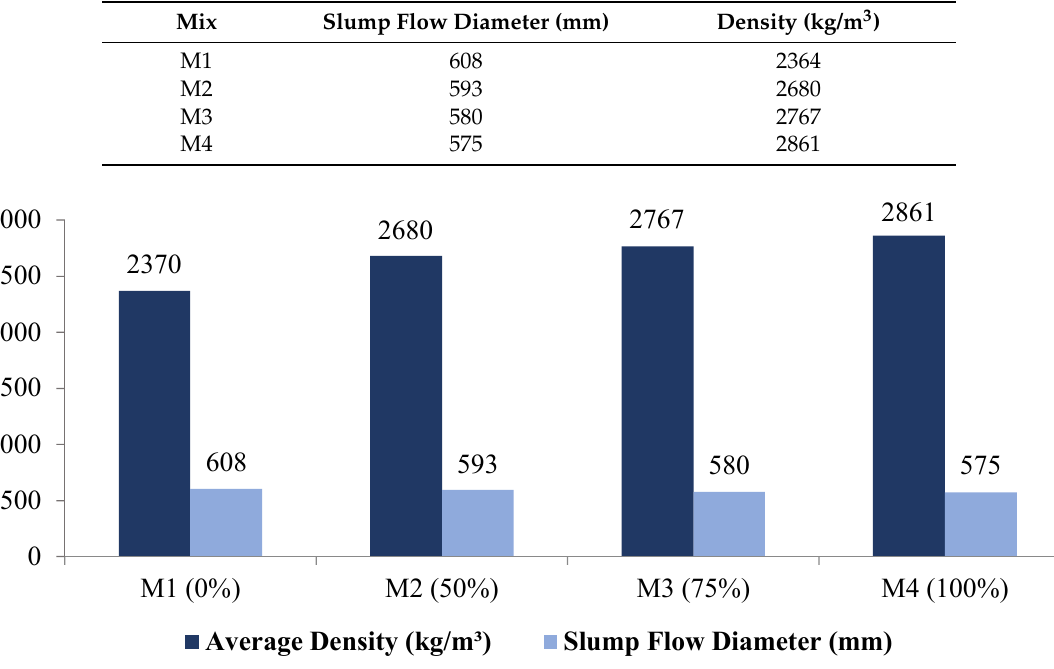
Figure 2. Fresh property test results.